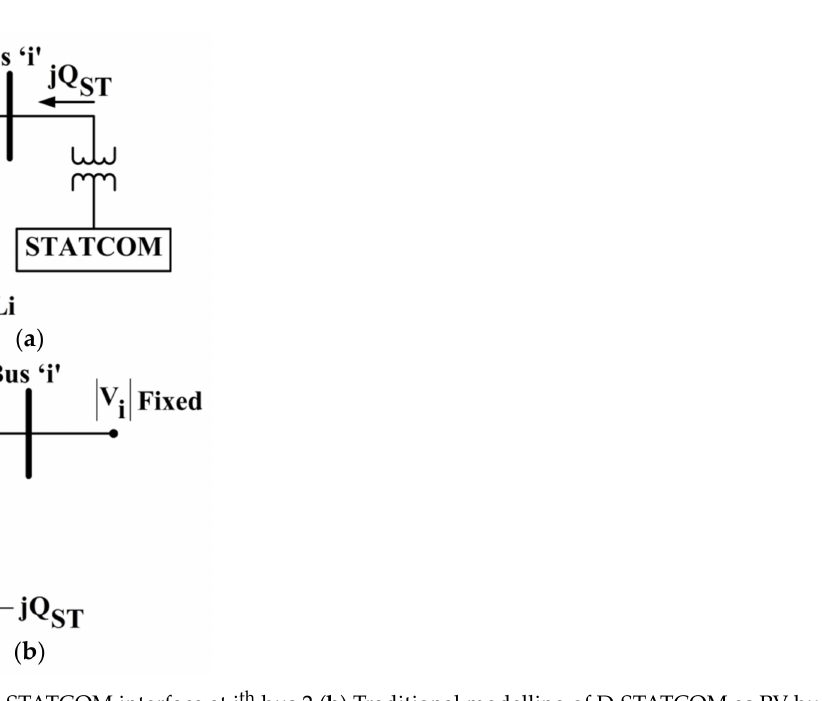
Figure 2. ( a ) D-STATCOM interface at i th bus 2 ( b ) Traditional modelling of D-STATCOM as PV